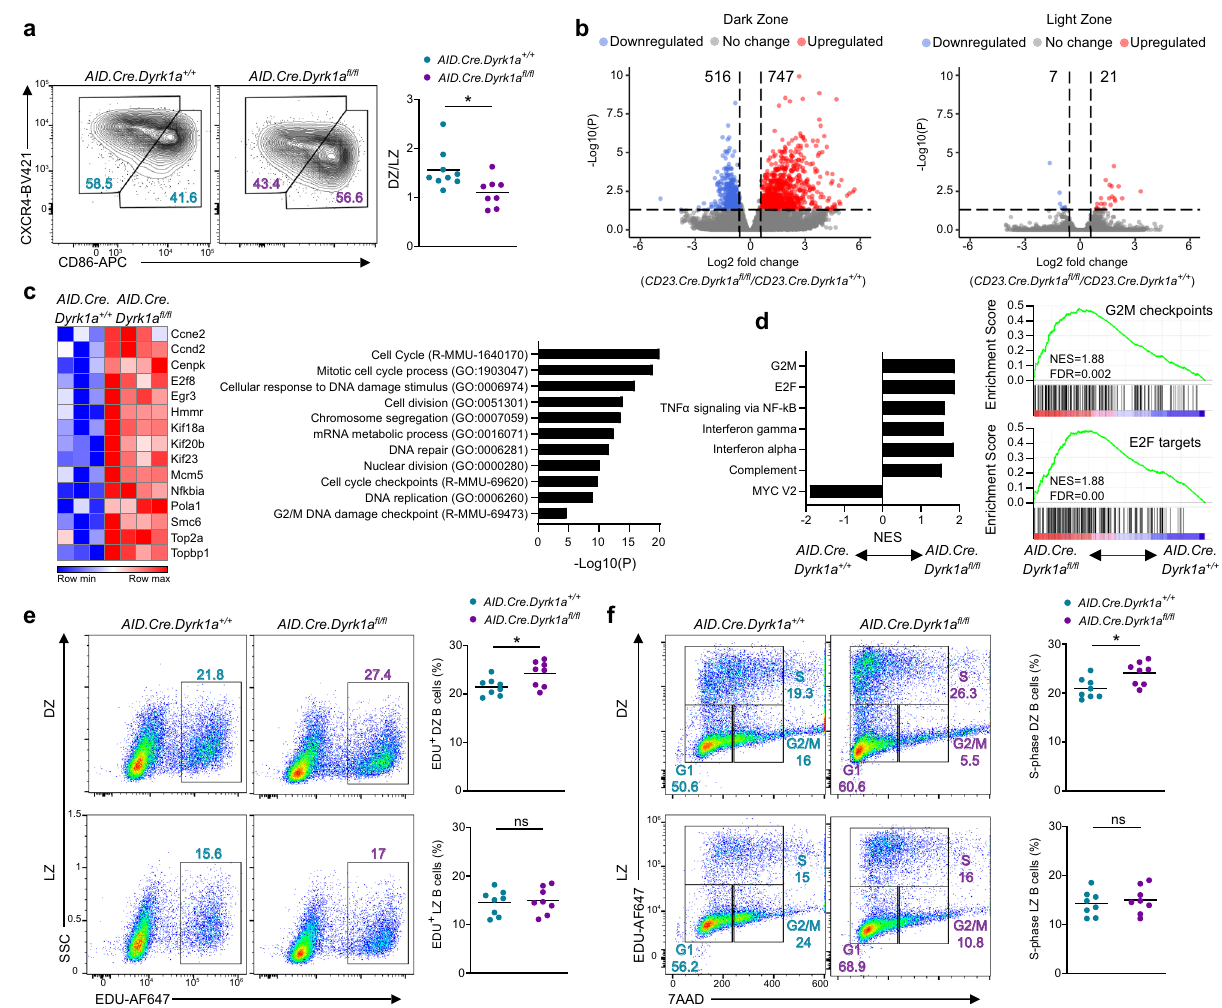
Fig. 6 | DYRK1A is a negative regulator of cell-cycle progression in GC B cells. a Representative fl ow cytometry plots and ratio of DZ to LZ GC B cells in popliteal LNs 7 days after NP-KLH immunization ( n =8 – 9; four independent experiments, two-tailedStudent ’ s t test). b Volcanoplotsshowingdifferentialgeneexpressionin the LZ and DZ of GC B cells derived from mice, as in ( a ) ( n =3 – 4; two independent experiments). Colored points correspond to adjusted P value <0.05, and log2 FC>0.58 (red) or< − 0.58 (blue). c Heatmap of differentially expressed genes and biological pathway analysis of upregulated genes of DZ B cells, as in ( a )